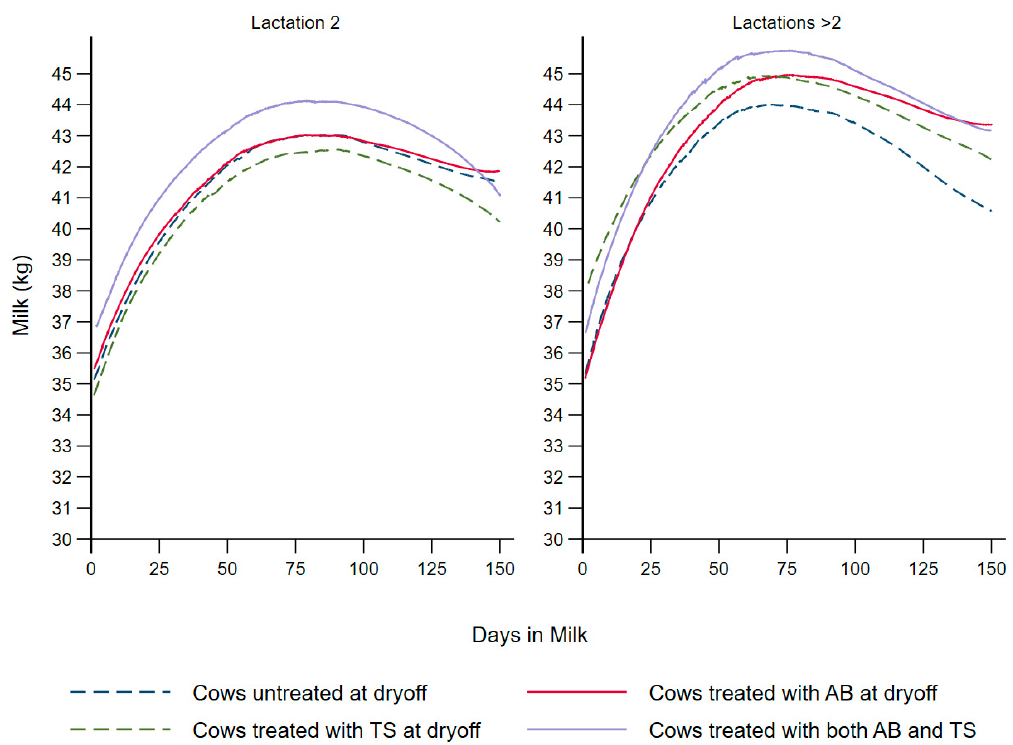
Figure 1. Locally weighted scatterplot smoothing of the predicted milk production curves for dairy cows that received different dry cow treatments (AB, TS, AB + TS or None) during the first 150 days in milk post-calving. AB: cows treated with intramammary antibiotics at dry-off. TS: cows treated with internal teat sealants at dry-off. AB + TS: cows treated with both intramammary antibiotics and internal teat sealants at dry-off. None: control group.